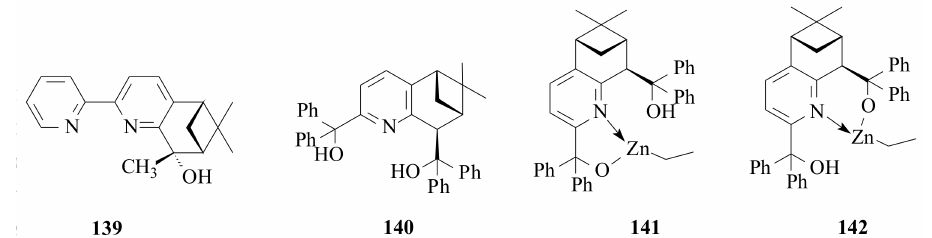
Figure 28. Sterically strained pyridinyl alcohols used in the diethylzinc addition reaction. Table 9. Asymmetric alkylation of substituted benzaldehydes using Et 2 Zn in the presence of ligand 139 . Substituent c.y. (%) ee (%) Conf. H 83